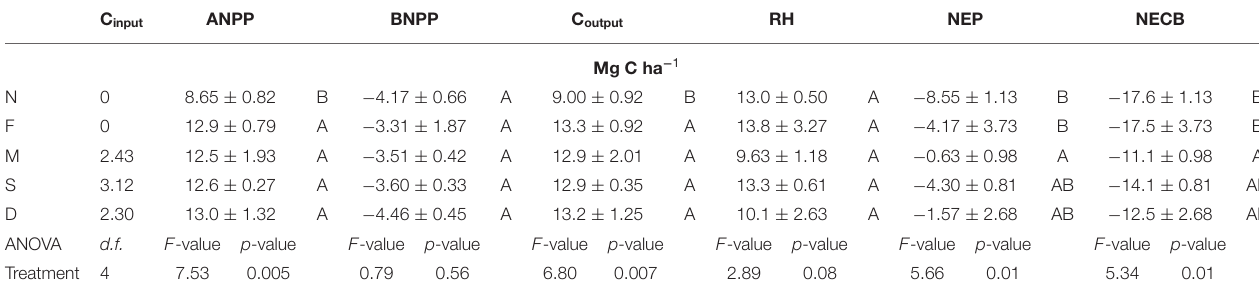
TABLE 5 | Net ecosystem carbon balance. C